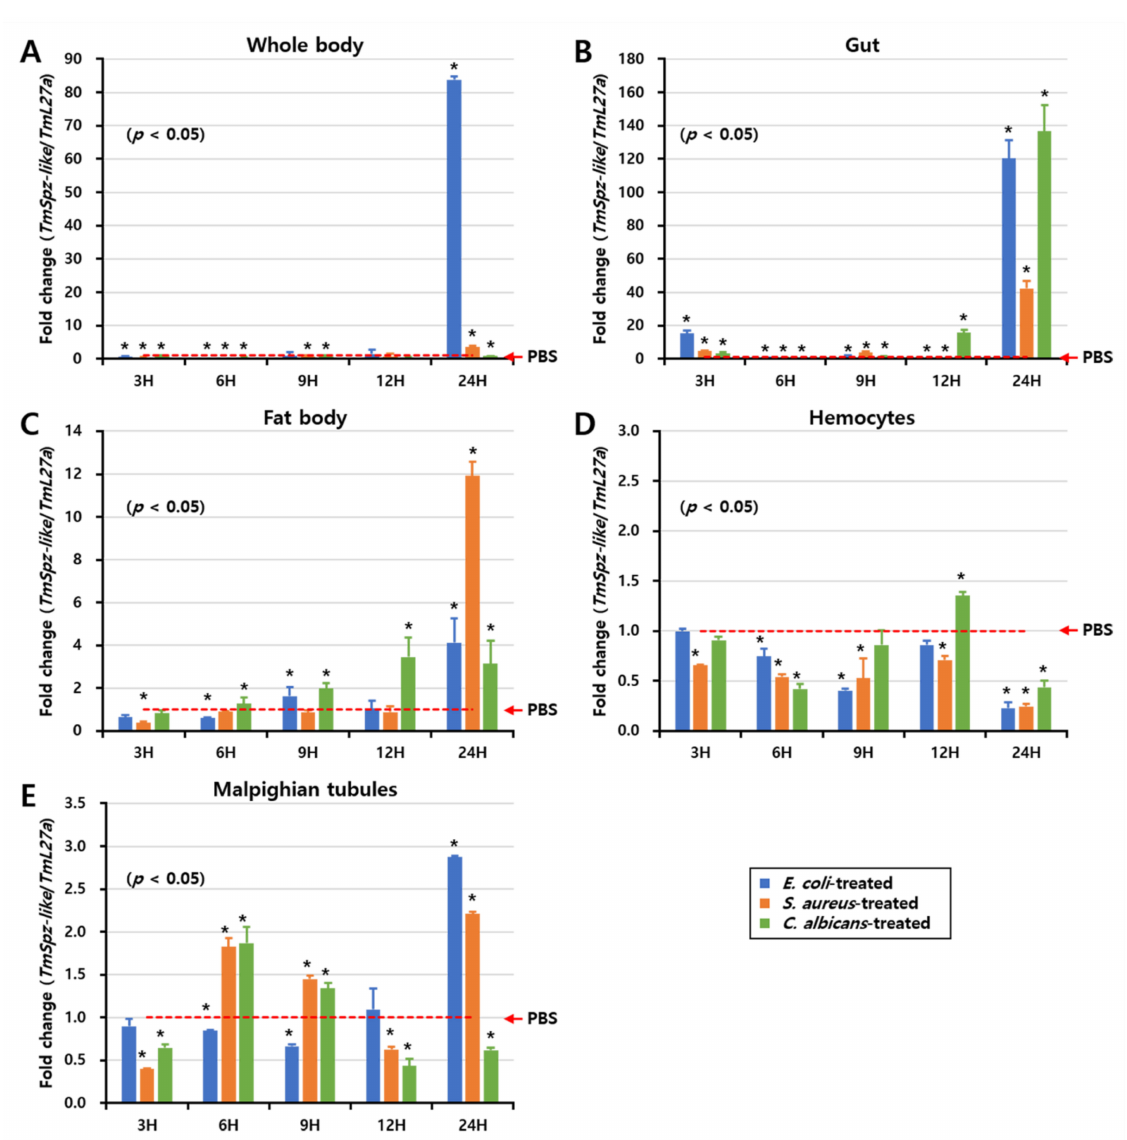
Figure 4. TmSpz-like mRNA expression profiles after microbial challenge. TmSpz-like relative expression levels in the whole body ( A ), gut ( B ), fat body ( C ), hemocytes ( D ), and Malpighian tubules ( E ) of larvae infected with Escherichia coli , Staphylococcus aureus , and Candida albicans. The mock control group comprised phosphate-buffered saline-treated larvae. Expression levels of TmSpz-like mRNA in the mock control group were normalized to 1. Vertical bars represent mean ± standard error from three biological replicates. Significant differences between the experimental and control groups are indicated by asterisks (* p <